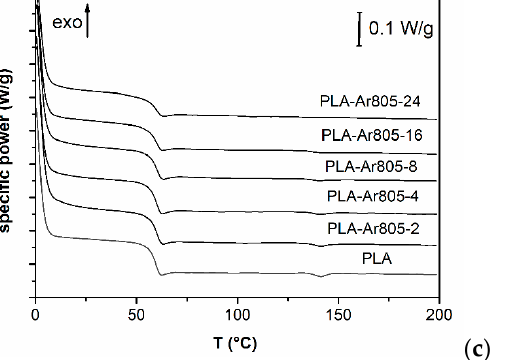
T g1 = glass transition temperature (first heating stage). T m1 = melting temperature (first heating stage). W c1 = crystallinity degree (first heating stage). T gC = glass transition temperature (cooling stage). T g2 = glass transition temperature (second heating